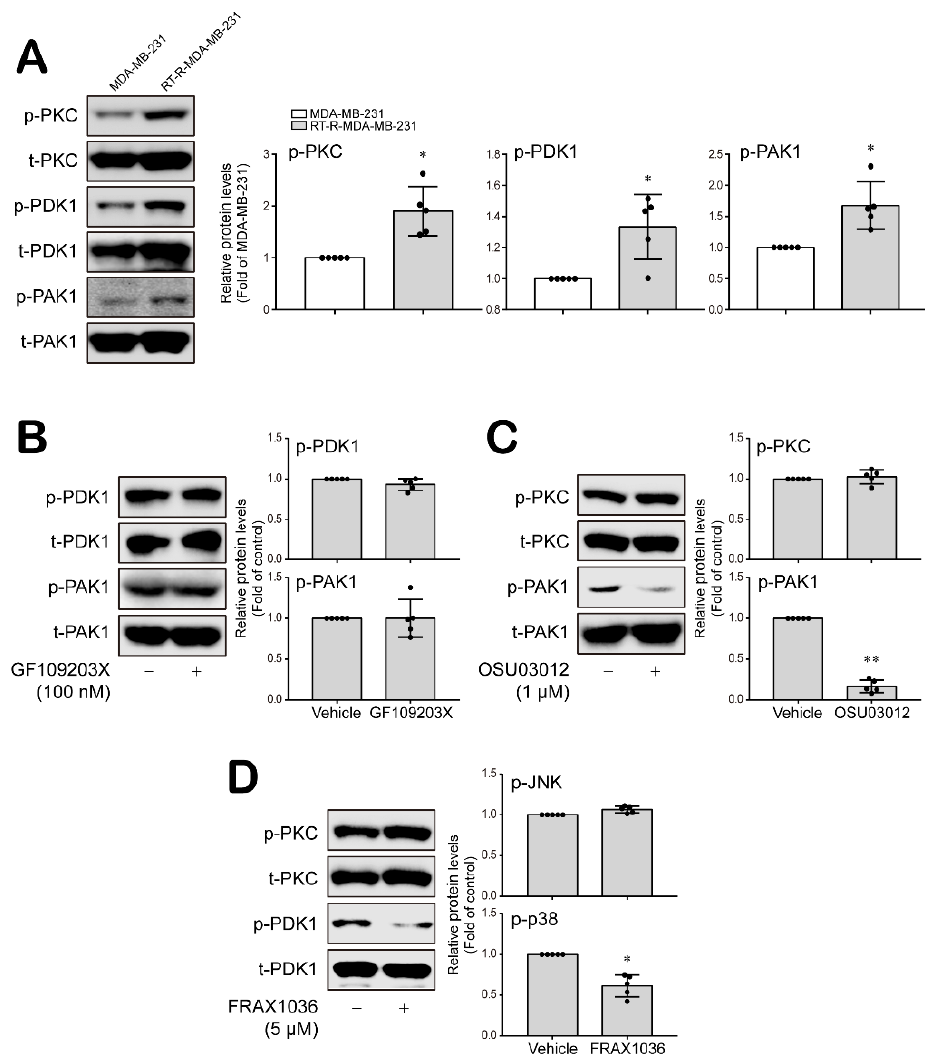
Figure 4. PDK1 and PAK1, which were activated in RT-R-MDA-MB-231 cells, interacted with each other but not with PKC. ( A ) Proteins were collected from MDA-MB-231 and RT-R-MDA-MB-231 cells, and phospho- and total-PKC, PDK1 and PAK1 protein levels were analyzed by Western blotting. The values are presented as the mean ± SD of five independent experiments. * p < 0.05 compared to the MDA-MB-231 cells. ( B – D ) RT-R-MDA-MB-231 cells were treated with GF109230X (100 nM) for 15 min, OSU03012 (1 µM) for 30 min, and FRAX1036 (5 µM) for 10 min. Total protein was extracted from the cells, and then phospho- and total-PDK1, PAK1 and PKC protein levels were analyzed by Western blotting. The values are presented as the mean ± SD of five independent experiments. * p < 0.05, ** p < 0.01 compared to the control.